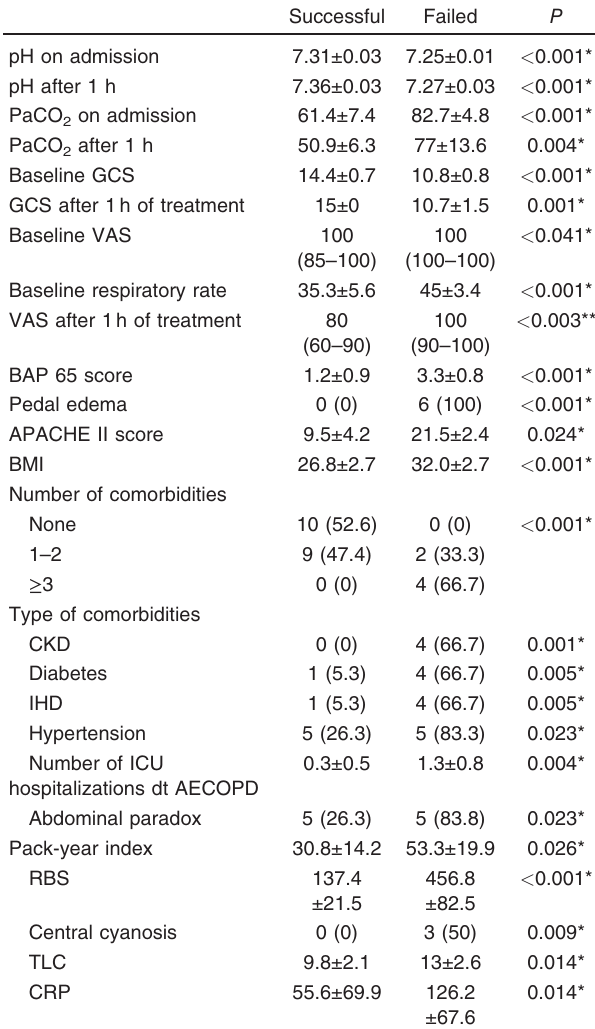
Table 13 Predictors of primary outcome for patients of group I